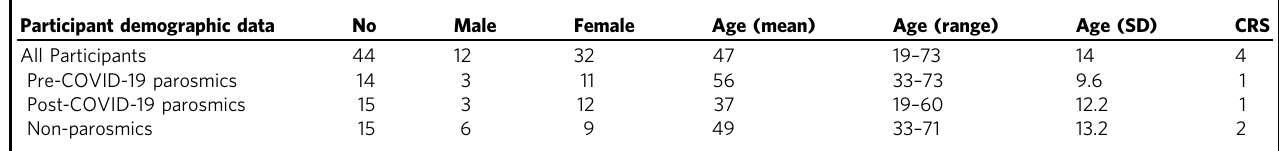
Table 1 Summary of participant